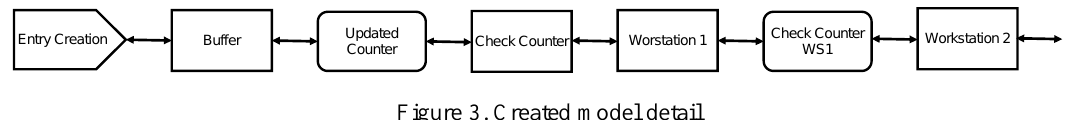
Figure 3. Created model